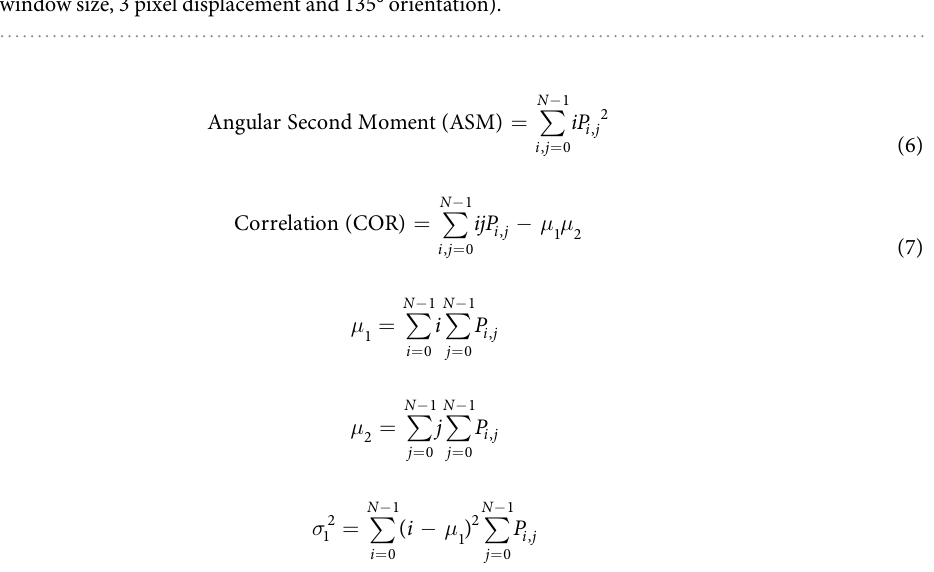
Figure 10. Subsets of ASM, CON, COR, DIS, ENT, HOM and VAR (which were calculated using a 3 × 3 moving window size, 3 pixel displacement and 135°